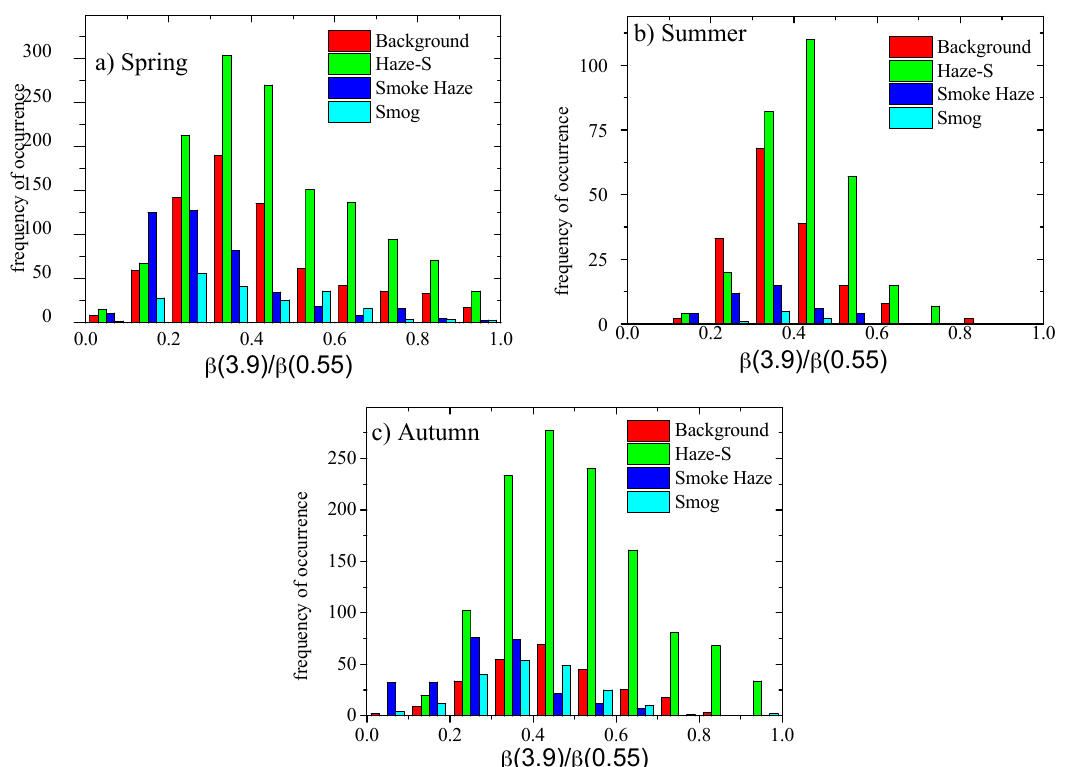
Figure 6. Histograms of the distribution of the parameter CD = β (3.9) / β (0.55) in three seasons: spring ( a ), summer ( b ), and autumn ( c ).